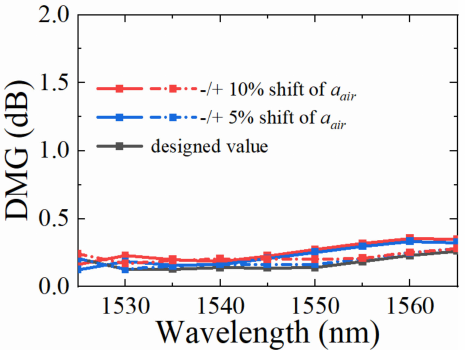
Figure 7. DMG versus wavelength under the shift of central air hole.